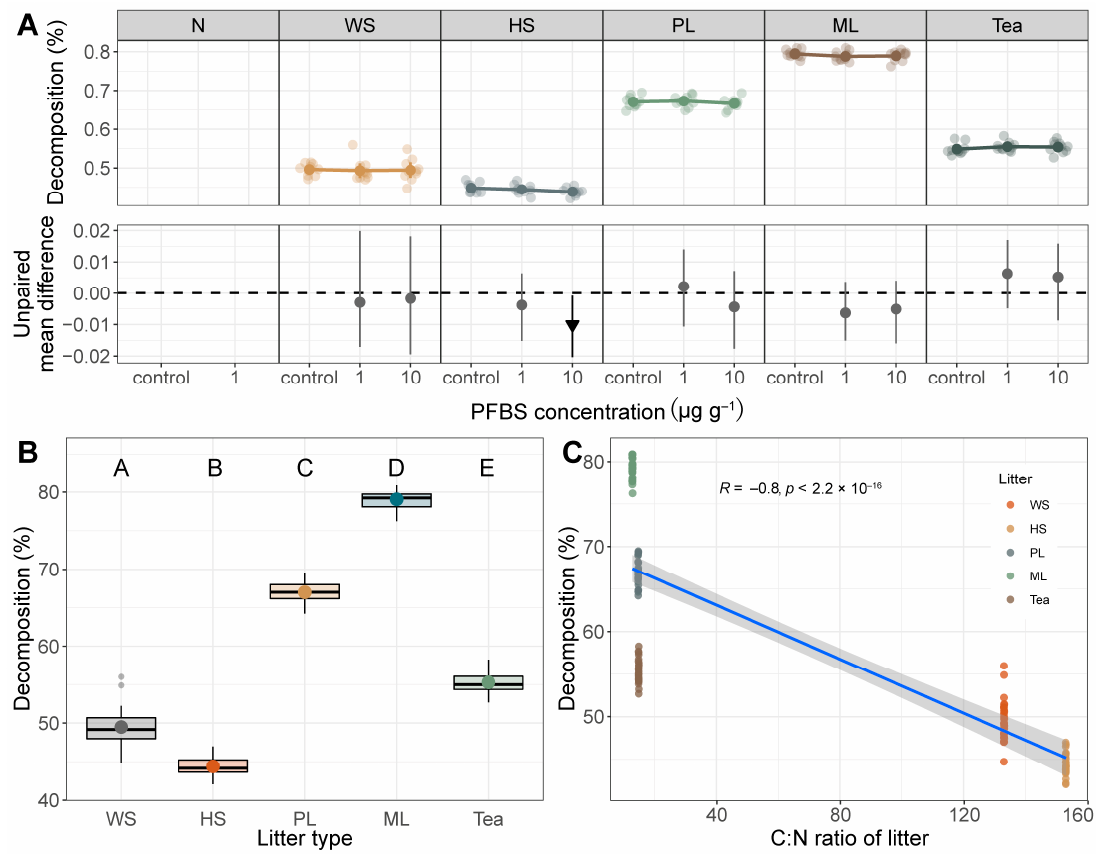
Figure 1. ( A ) Response of litter decomposition to PFBS concentrations within litter type; ( B ) Response of litter decomposition to litter type regardless of PFBS concentrations; ( C ) Correlations of litter decomposition with the C:N ratio of litter. The second row of the panel ( A ) showed the comparison of the unpaired mean difference between the treated and control group within a 95% confidence interval (CI). The grey spots indicated the neutral effects while the black arrows pointing downwards represented negative effects. Different letters above the boxes in panel ( B ) indicated statistically significant differences among treatments at p < 0.05. N, no litter; WS, wheat straw; HS, hemp stem; PL, Plantago lanceolate ; ML, Medicago lupulina .